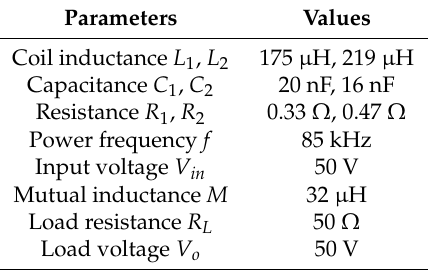
Figure 11. Prototype of proposed SWIPT system. Table 1. System Parameters.